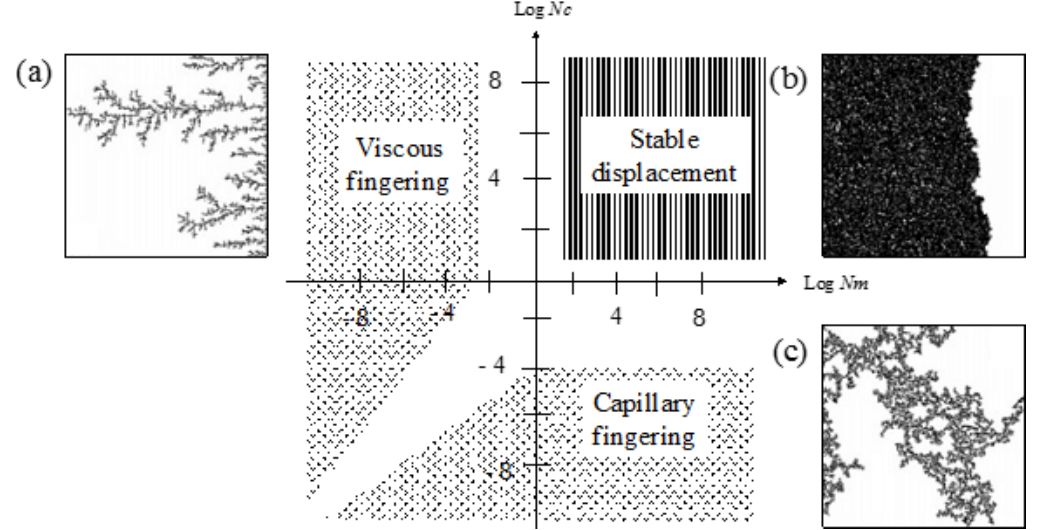
Figure 1. Displacement pattern with respect to N m and N c : ( a ) viscous fingering; ( b ) stable displacement; and ( c ) capillary fingering [32,46].